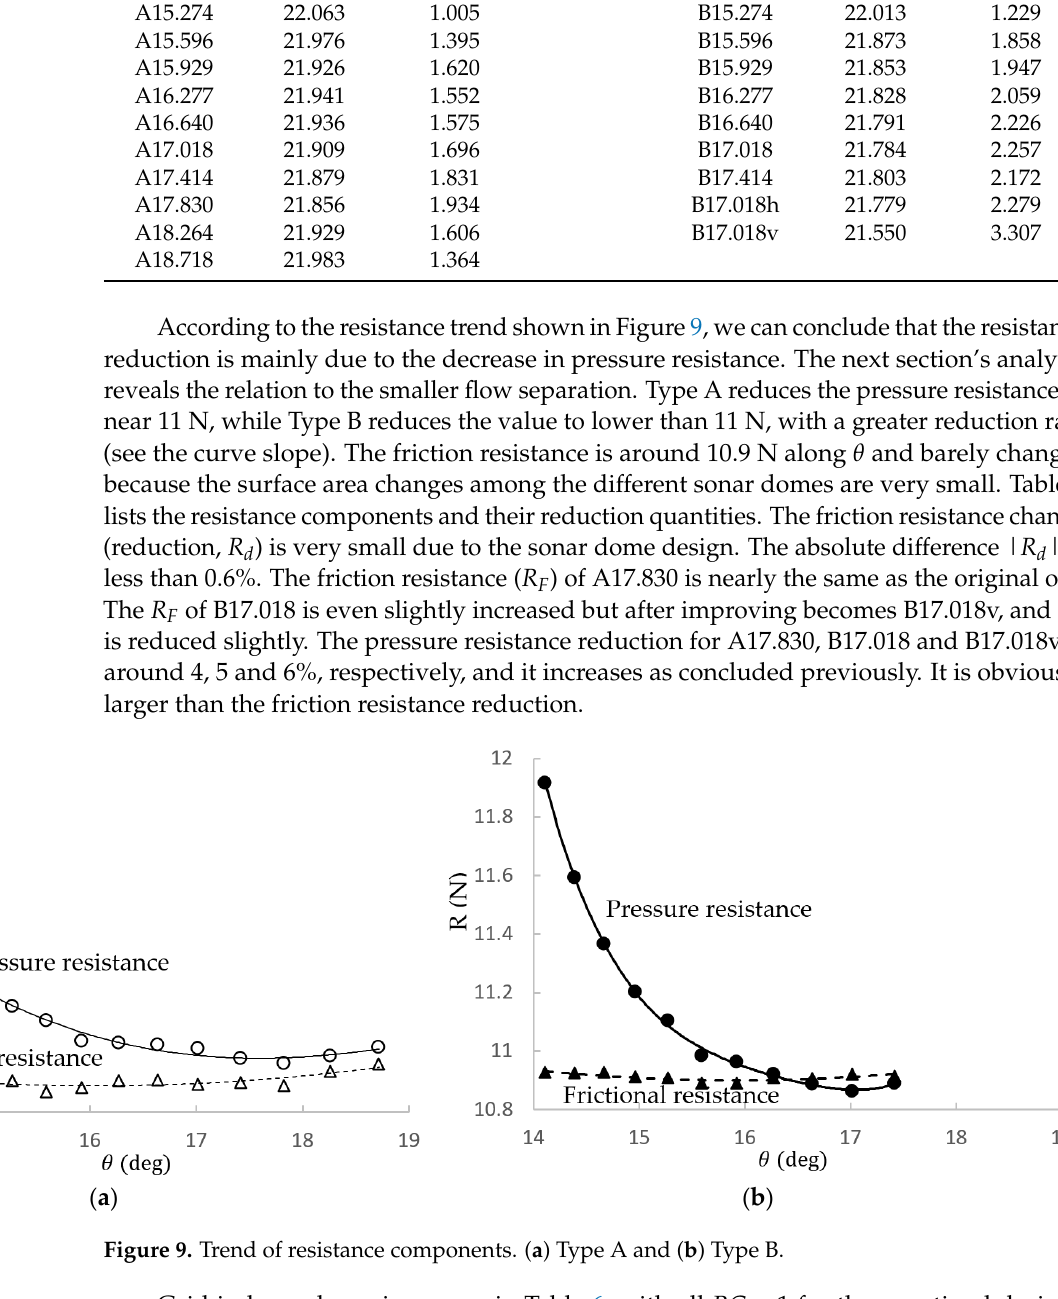
Table 5. Comparison of resistance components for different sonar dome configurations.